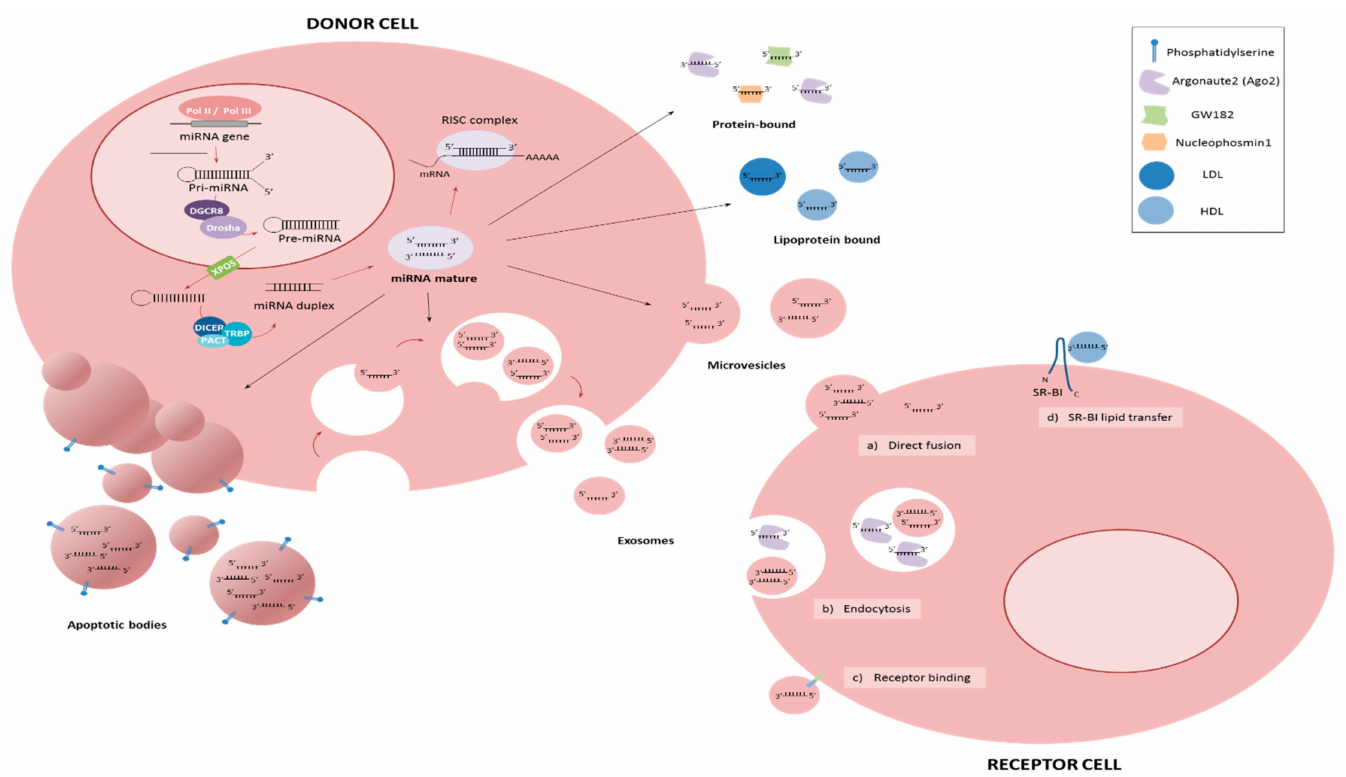
Figure 1. The release of microRNAs (miRNAs) in the extracellular environment. MiRNAs could enter the RNA induced silencing complex (RISC) to regulate mRNA expression and / or translation or can be released outside cell to reach biological fluids. Circulating miRNAs could be found in two major forms, vesicle associated and non-vesicle associated. When miRNAs are released by donor cells through vesicles, these could be microvesicles by outward budding (100–1000 nm), exosomes (50–100 nm) or apoptotic bodies as a result of apoptosis (1–5 µ m). On the other hand, cell-free miRNAs could be found bound to proteins, such as Argonaute2 (AGO2), GW182 and Nucleophosmin1 (NPM1), or bound to lipoproteins, high-density lipoproteins (HDLs) or low-density lipoproteins (LDLs) [8]. Circulating miRNAs uptake by receptor cells occurred by membrane direct fusion ( a ), endocytosis ( b ) and receptor binding ( c ), which could trigger a downstream cascade or could produce internalization of the vesicle [9,10]. Moreover, it has been demonstrated that delivery of HDL miRNAs is dependent on scavenger receptor class B type I (SR-BI)